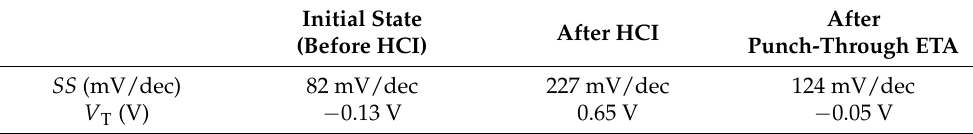
Table 3. Extracted device parameters before HCI, after HCI and ETA.